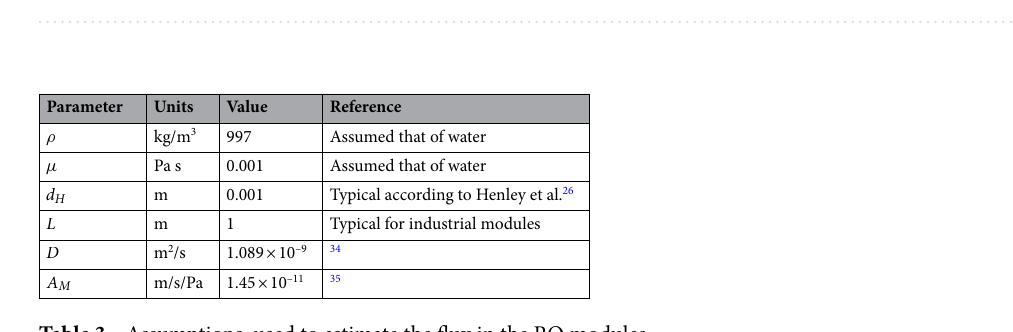
Table 2. The feed side concentration, flux and hydraulic pressure, by Lee and Kim 35 — Permeate concentration ≅ 0.